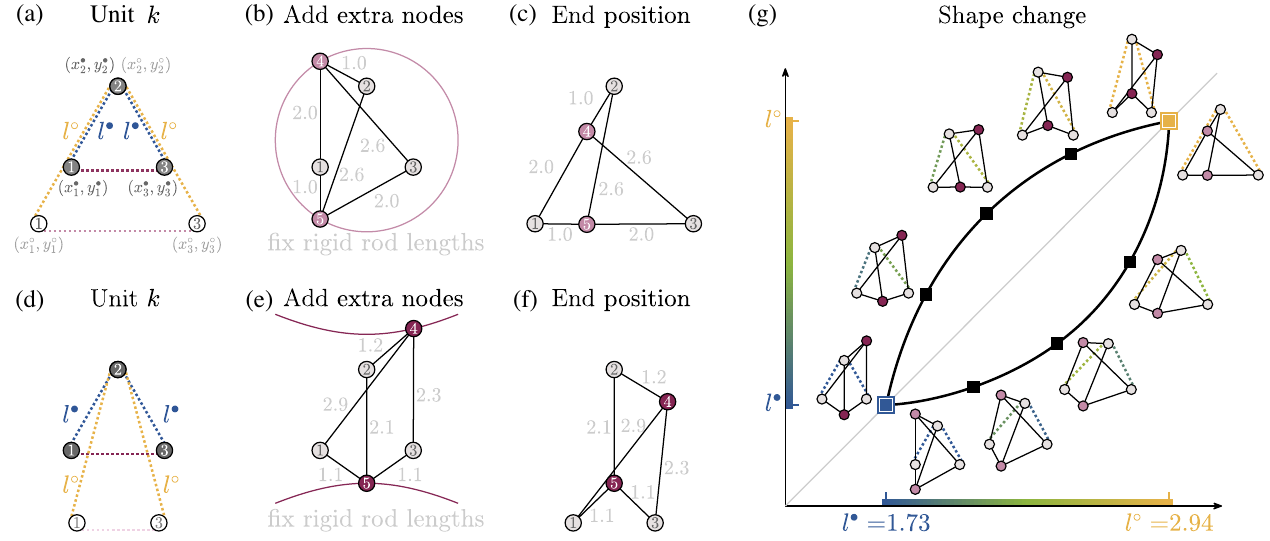
FIG. 7. Designing unit geometry at fixed points. (a) Node coordinates that start at a fixed point l (cid:129) and end at another fixed point l ∘ , where the length c is larger at the end than at the start such that c ∘ > c (cid:129) . In (b), the maroon curve is the solution space. By placing extra nodes 4 and 5 on the solution space and fully connecting them to nodes 1, 2, and 3 with rigid bonds, (c) there exists an end position of nodes 4 and 5 that keeps all bond lengths the same. (d) Another unit with the same start fixed point l (cid:129) and end fixed point l ∘ , but with the length c chosen to be smaller at the end than at the start such that c ∘ < c (cid:129) . (e) By placing extra nodes 4 and 5 on the solution space and connecting them to nodes 1, 2, and 3 with rigid edges, (f) there exists an end position that retains all bond lengths. (g) Plots of the conformational motion of both units as they change shape from the start fixed point to the end fixed